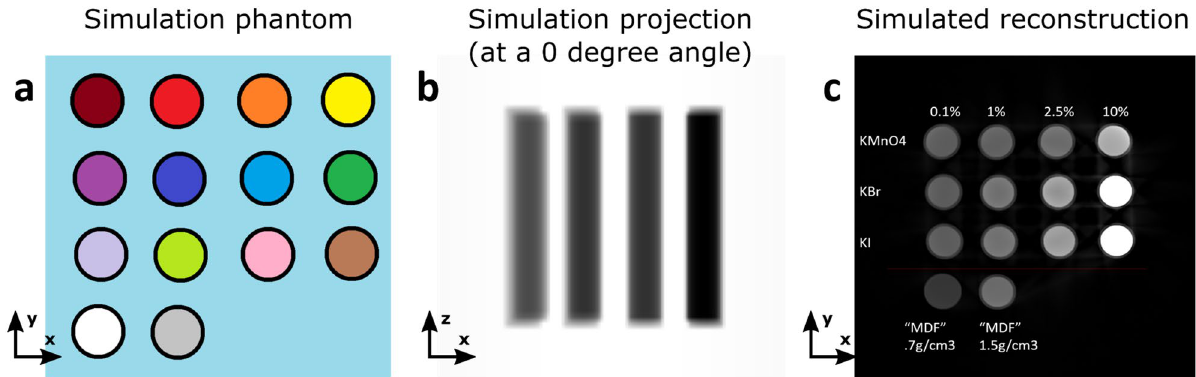
Figure 5. Arion simulation framework of X-ray projections ( b ) of a phantom ( a ) consisting of an array of Eppendorf tubes (the phantom is panned in the vertical direction). From the simulated projections at different angles, CT reconstruction ( c ) can be done to examine the expected X-ray attenuation contrast between different